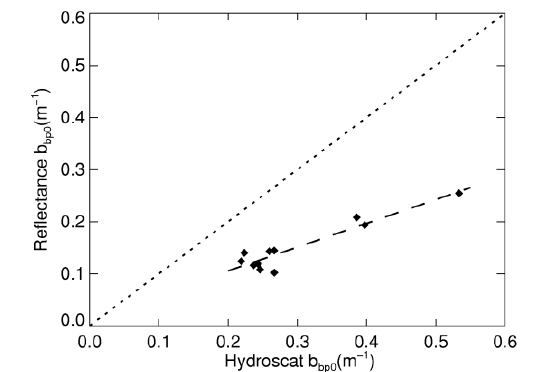
Figure 4 The Hydroscat-6 derived b bp0 vs Reflectance derived bb p0 for the Burdekin Falls Dam stations. The dashed line shows a line of best fit for the data and the dotted line is a 1:1 correspondence line.